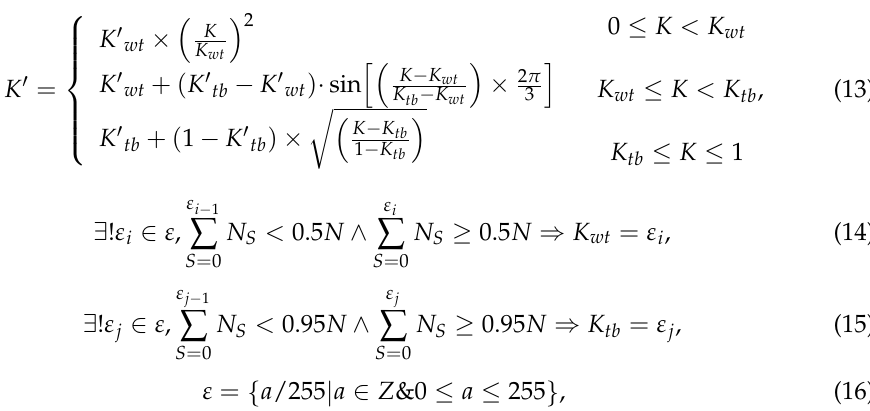
S . The parameters K wt and K tb are the adjusted upper limits of the intensity value of image